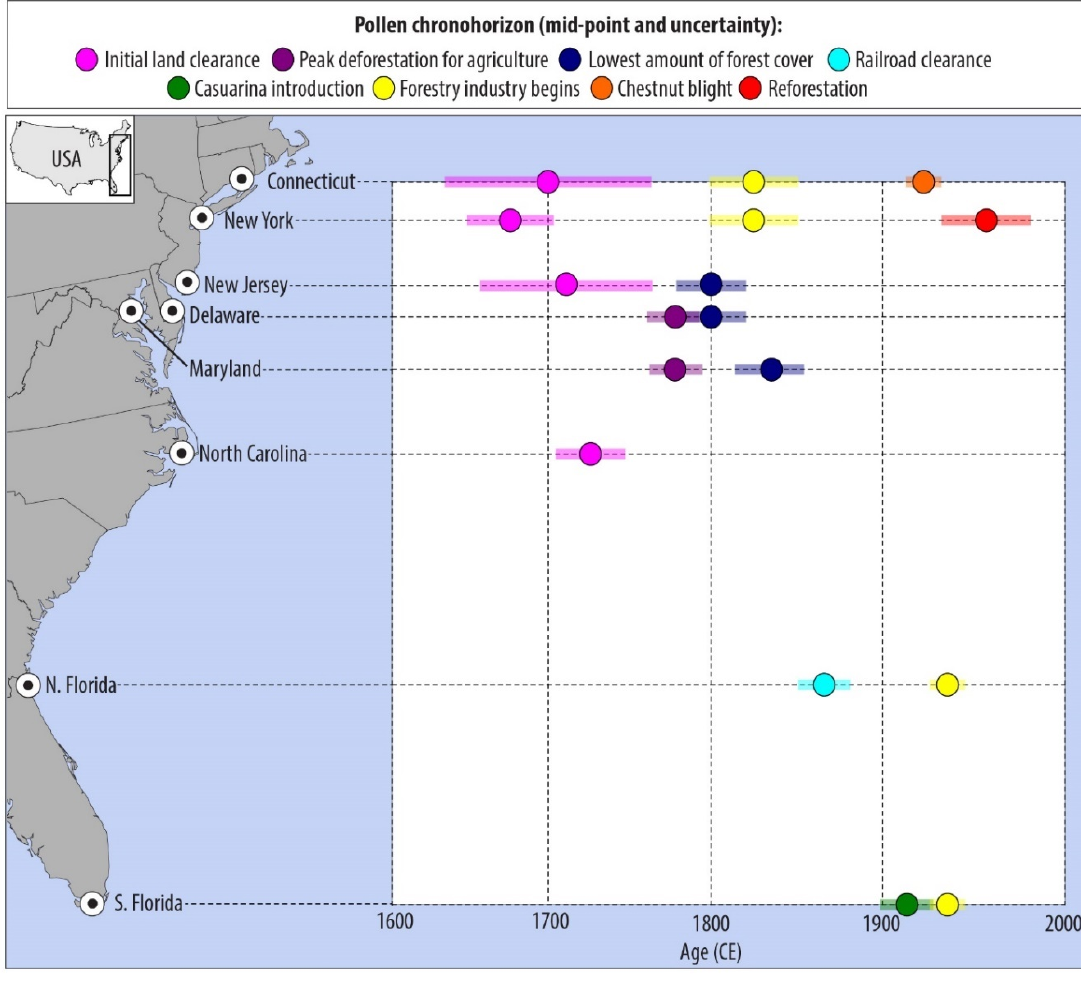
Figure 3. Timing of pollen chronohorizons documented in the literature at each study site. Pollen data from published sites are available in the original publications. Table 3. Site pollen chronohorizons, their ages, and the ages predicted by NP Bchron model. 1a to 3b refers to the pollen chronohorizon identifier, with the numerical portion of the identifier designating the type of chronohorizon: (1) land clear- ance; (2) reforestation; and (3) introduction and loss of taxa, and the letter portion designating the specific chronohorizon (e.g., Chestnut blight). (Figure 4, Appendix C).